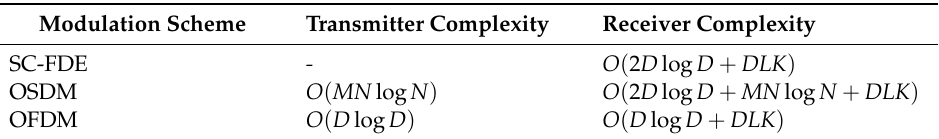
Table 2. The system complexity of single-carrier frequency-domain equalization (SC-FDE), orthogonal frequency division multiplexing (OFDM) and OSDM.